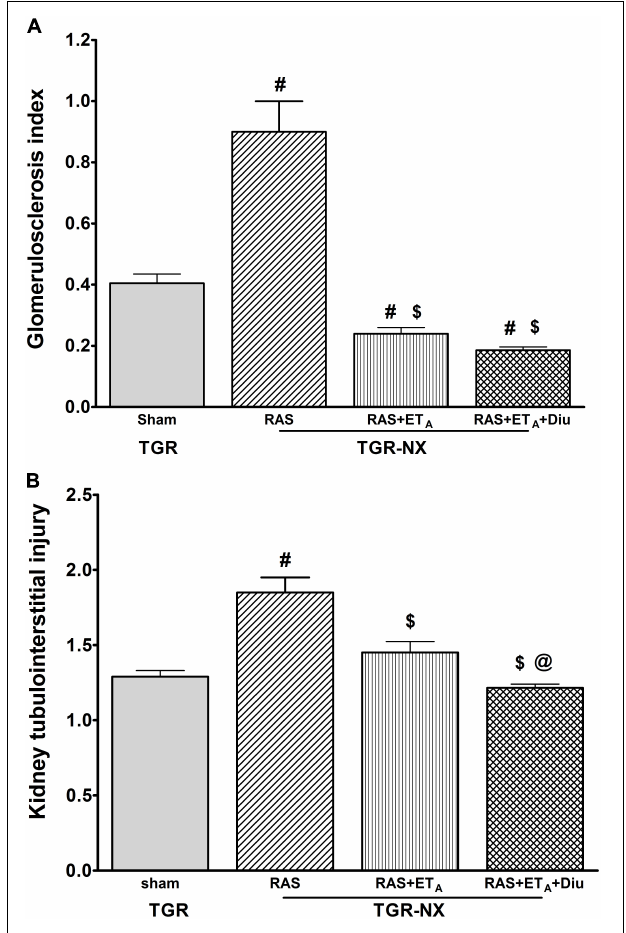
FIGURE 4 | The effect of diuretic treatment added to combined RAS and ET A blockade on relative kidney weight and glomerular area. Relative kidney weight (A) and glomerular area (B) in sham-operated heterozygous Ren-2 transgenic rats (TGR-sham), nephrectomized TGR (TGR-NX) treated with the renin-angiotensin system blockade alone (RAS), combined RAS + ET A blockade (RAS + ET A ); or diuretic given with the combined RAS + ET A blockade (RAS + ET A + Diu). # P < 0.05 TGR-sham vs. other TGR-NX-treated groups, Diu – diuretic. # P < 0.05 TGR-sham vs. other TGR-NX-treated groups, @ P < 0.05 TGR-NX + RAS + ET A + diuretic vs. other TGR-NX-treated groups.